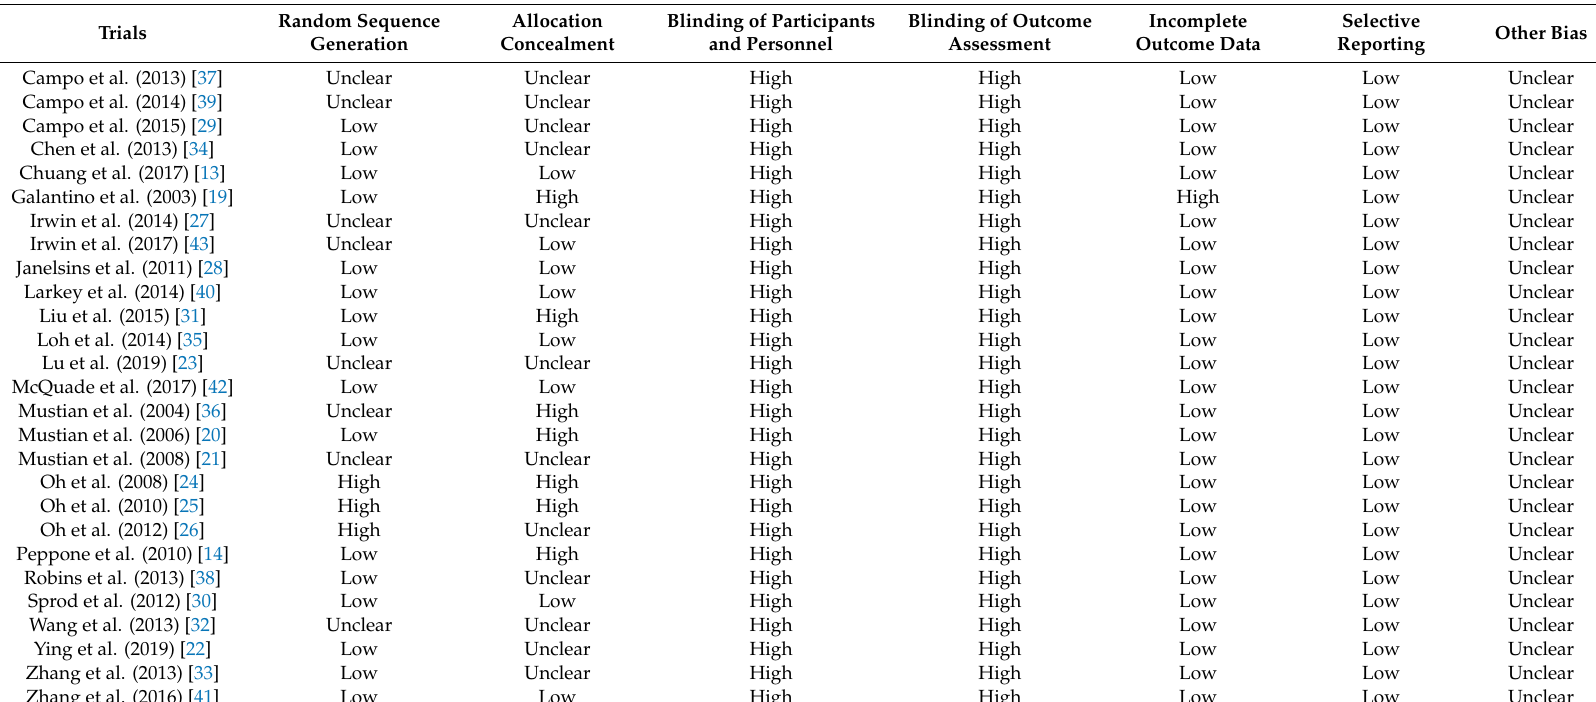
Table 1. Risk of bias evaluation of included